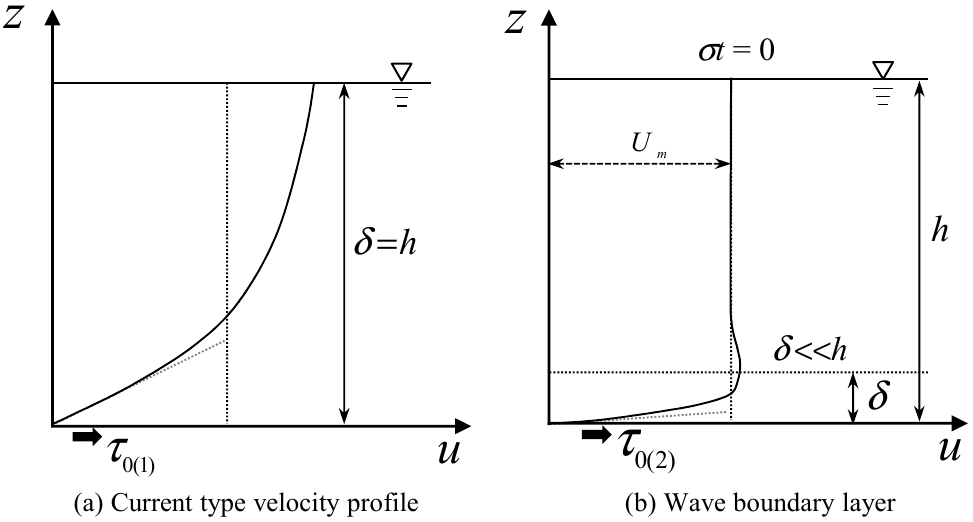
Figure 1. Difference between ( a ) the current-type velocity profile and ( b ) the wave boundary layer.